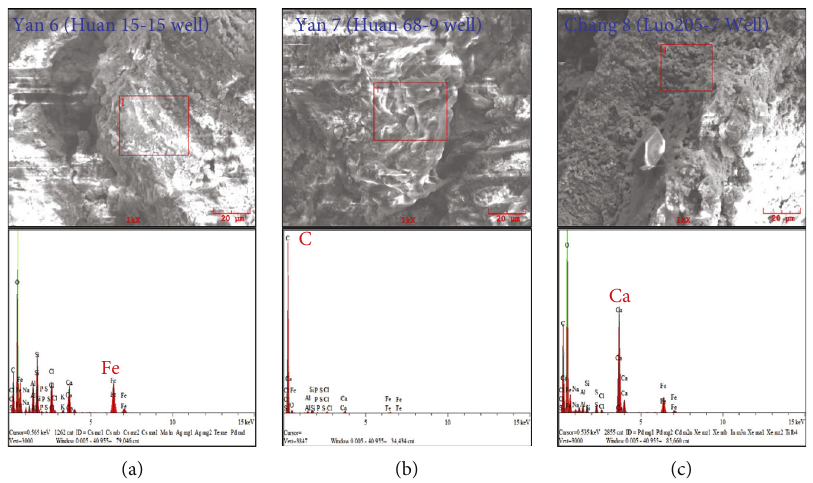
Figure 6: Test results of typical scale samples from di ff erent wells.